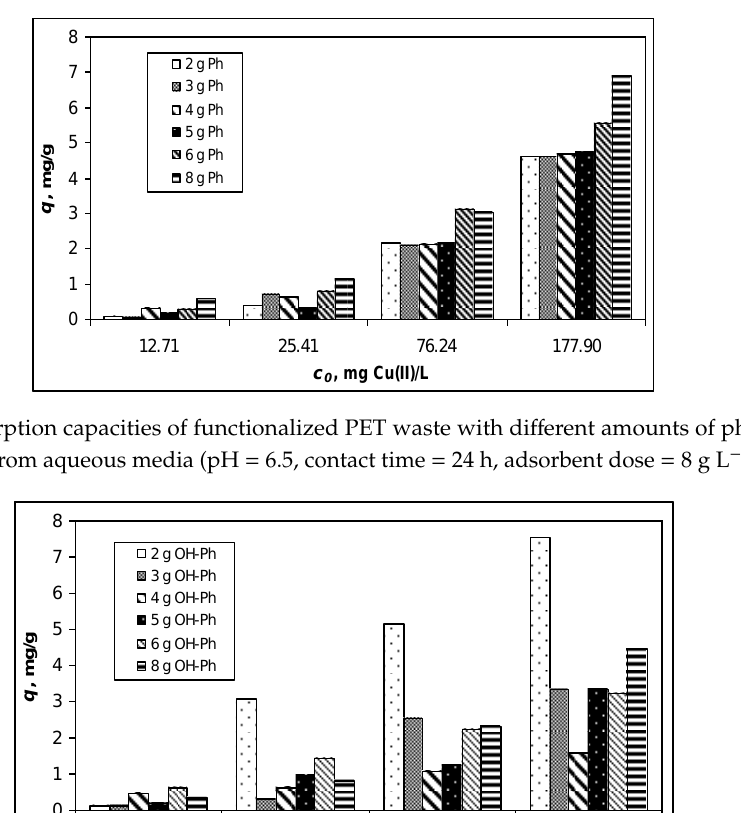
Figure 3. Adsorption capacities of functionalized PET waste with different amounts of hydroxyquinone (OH-Ph), for Cu(II) ions from aqueous media (pH = 6.5, contact time = 24 h, adsorbent dose = 8 g L −1 ).